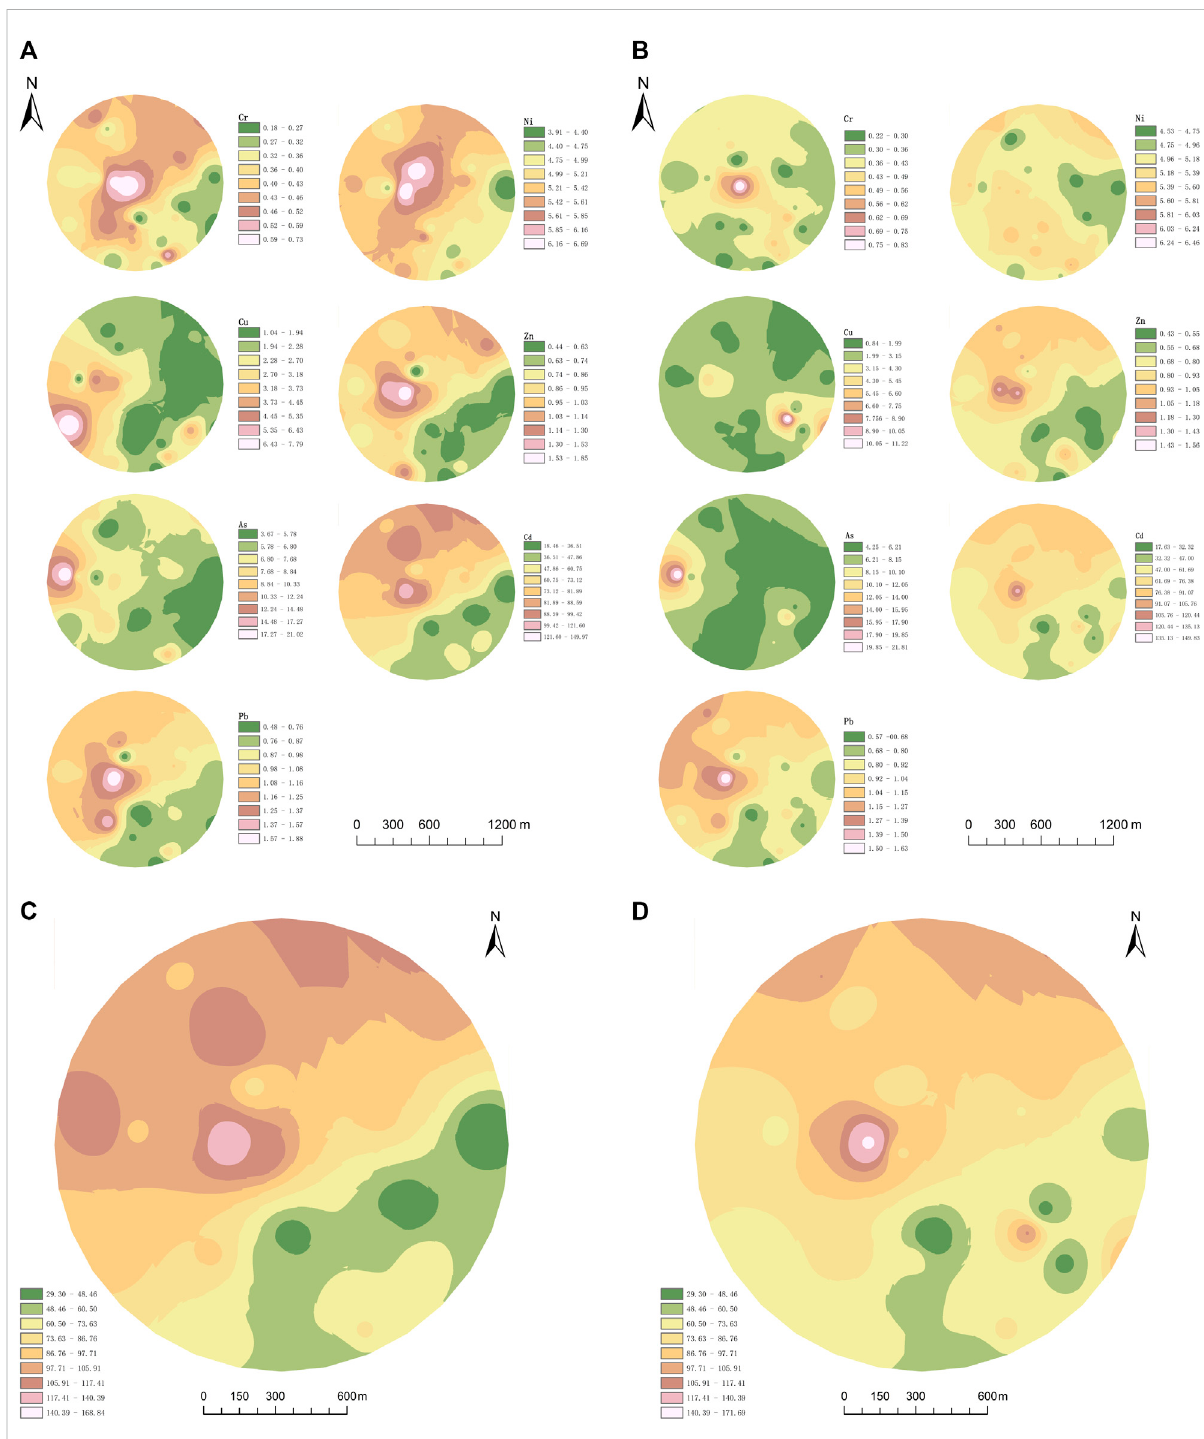
FIGURE 4 Spatial distribution of potential ecological risks of soil heavy metals. *Stars represent the waste